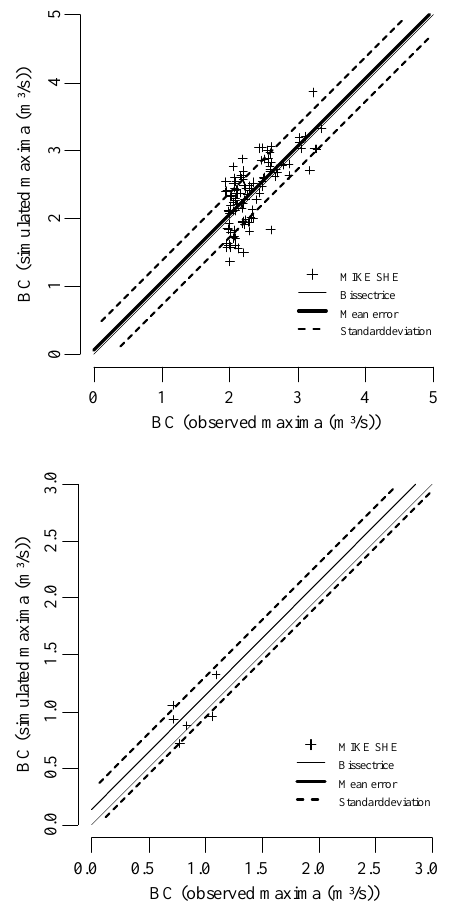
Fig. 10. (a) Scatter plot of simulated versus observed independent hourly peak flows at the outlet station of the Grote Nete catchment after Box–Cox transformation ( λ = ˙ 0.25). (b) Scatter plot of simu- lated versus observed independent hourly low flows at the outlet station of the Grote Nete catchment after Box–Cox transformation ( λ =0.25).